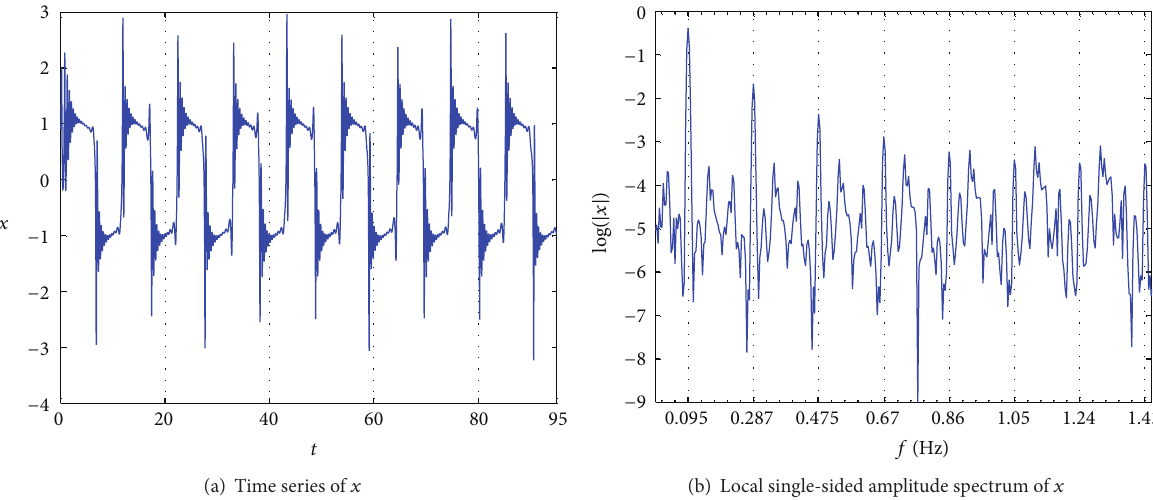
Figure 8: Time series and power spectrum of the system (6) with 𝐴 = 0.2 and 𝜔 = 0.6 .